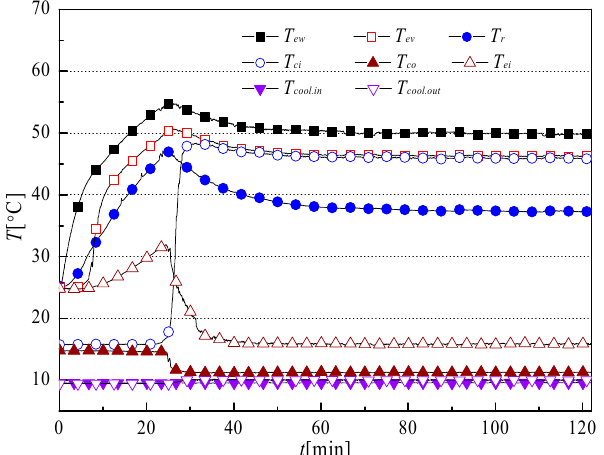
Figure 7. Start-up of the LHP with evaporator thermal load of 10 W in horizontal alignment.